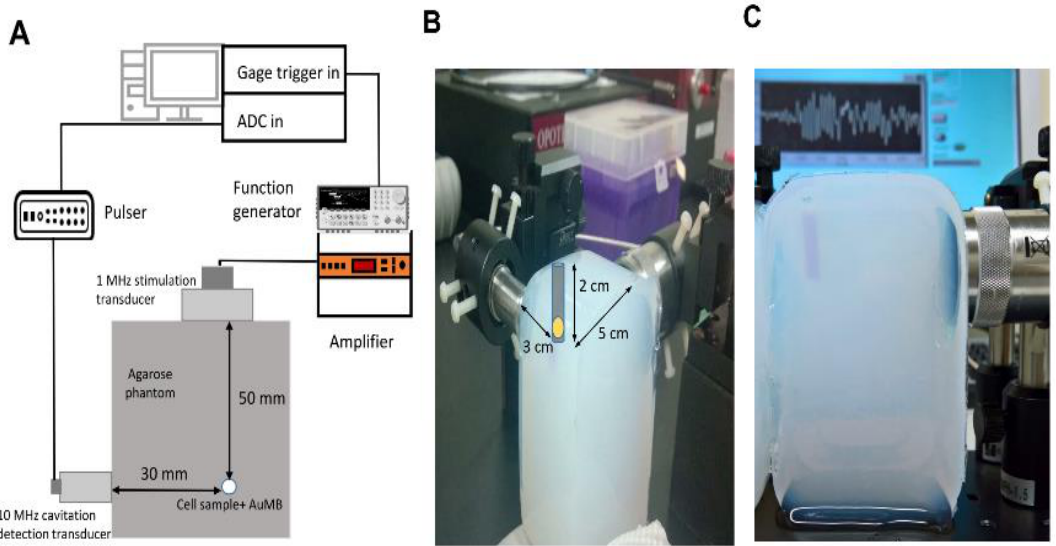
Figure 1. System setup for the ultrasound treatment and cavitation measurements. ( A ) Schematic of thein vitrotreatmentandinertialcavitationdose(ICD)measurementsystem. ( B )and( C )Water-equivalent agarose phantom with a prespecified cell well at the focuses of two ultrasound